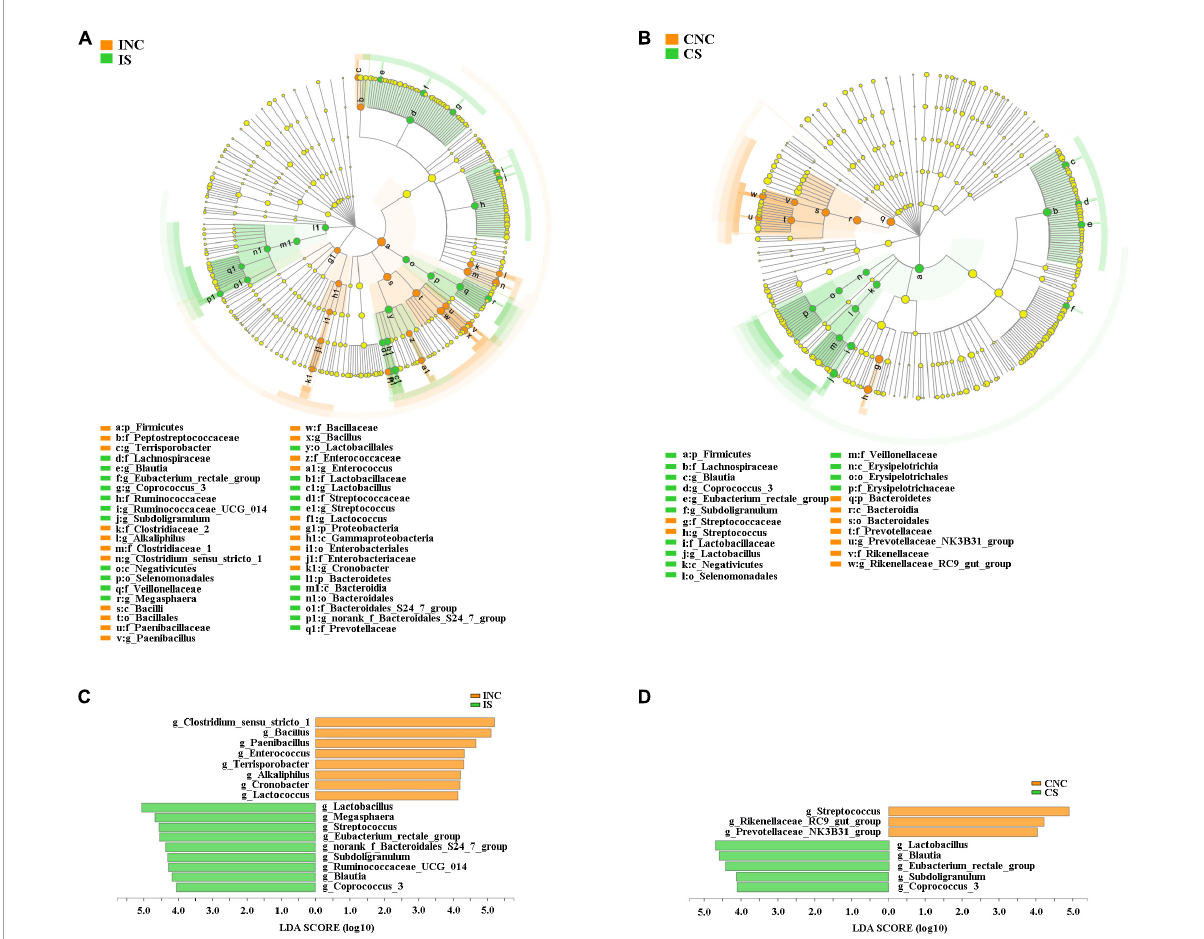
FIGURE5 Linear discriminant analysis (LDA) effect size analysis (LEfSe) analysis showed significantly changed ( P < 0.01) in bacteria between the control and treatment groups in the ileum and the colon. (A) Significantly changed bacteria between INC and IS from phylum to genus levels. (B) Significantly changed bacteria between CNC and CS from phylum to genus levels. (C) LDA bar chart showed significantly changed bacteria at genus level between INC and IS. (D) LDA bar chart showed significantly changed bacteria at genus level between CNC and CS. LDA score > 4 as the cutoff value. INC, ileum negative control; CNC, colon negative control; IS, ileum with 0.2% sodium butyrate; CS, colon with 0.2% sodium